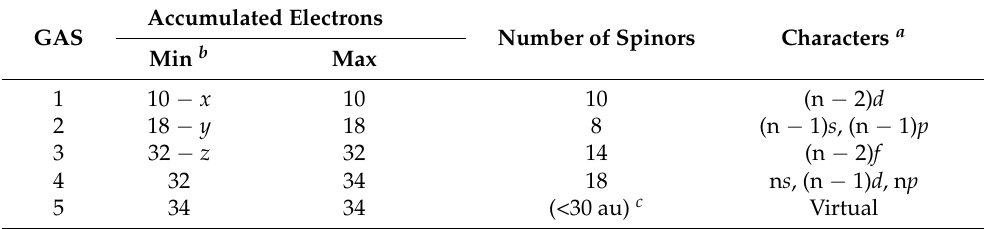
Table 1. Specification of the generalized active space (GAS) scheme used for the calculations for the Lu + and Lr + ions (see the text for